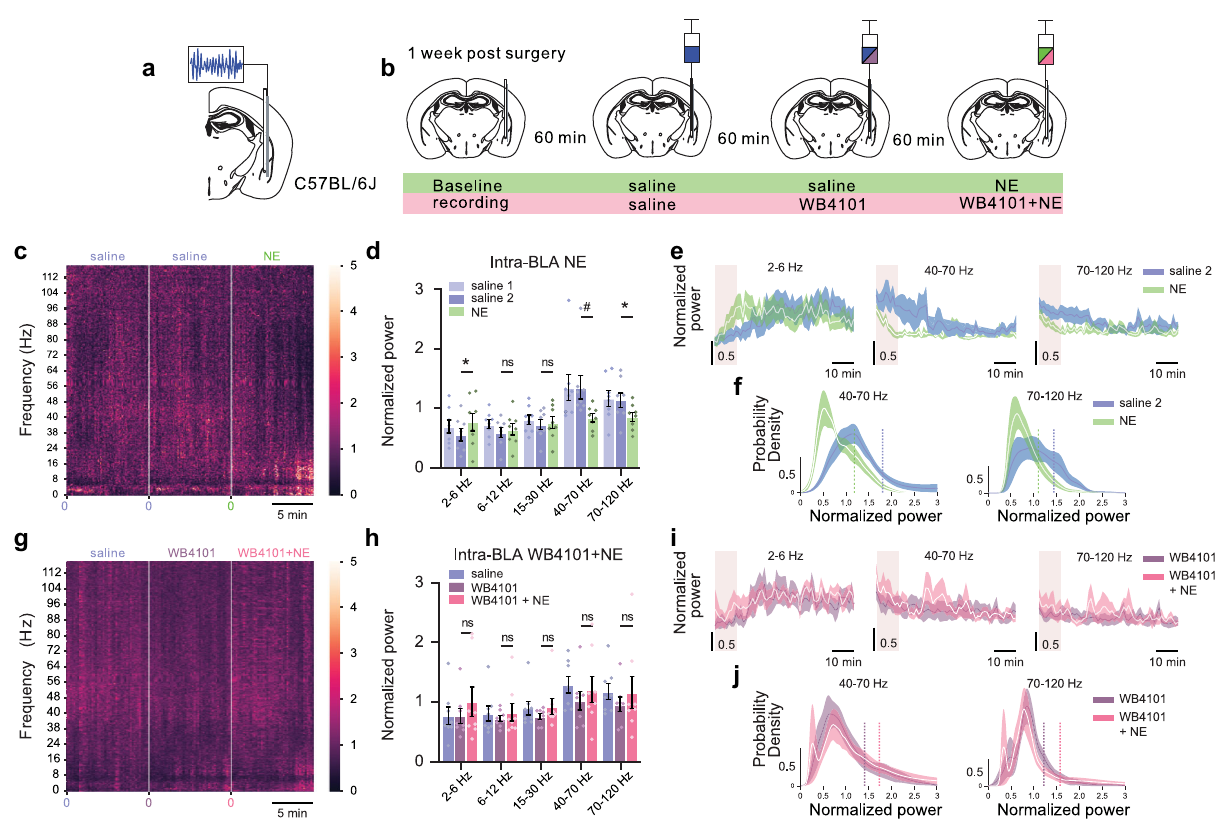
Fig. 7 α 1A adrenoreceptor signaling dynamically reorganizes BLA network states in vivo. a , b Schematics illustrating in vivo paired intra-BLA drug microinfusion and LFP recording paradigm. c Average spectrogram illustrating normalized power (0 – 5: low-to-high power) across frequencies over the fi rst 10min of saline 1, saline 2, and NE treatments. d Mean (±SEM) normalized power across treatments (Saline 1 vs. Saline 2 vs. NE) and frequency bands. Values from fi rst 10min of each treatment were included for analysis. Two-way ANOVA [treatment x frequency], F(1.659, 11.61) = 5.736, p = 0.0223; Tukey ’ s multiple comparisons test, 2 – 6Hz, p = 0.0319; 6 – 12Hz, p = 0.4088; 15 – 30Hz, p = 0.5979; 40 – 70Hz, p = 0.0784; 70 – 120Hz, p = 0.0131. n = 8 mice. # p = 0.0784, * p <0.05, ns not signi fi cant. e Normalized power across time for 2 – 6Hz (left), 40 – 70Hz (middle), and 70 – 120Hz (right). Values averaged into 1-min bins. Colored lines = average power over time, colored shaded areas = SEM. f Average probability density plots illustrating the distribution of gamma powers across treatments for 40 – 70Hz (left) and 70 – 120Hz (right). Blue/green solid lines = average probability, blue/green-shaded areas = SEM. Vertical lines indicate average threshold value for distribution tails, where threshold = 1 standard deviation above the mean. Paired t -test (two-tailed), saline 2 vs. NE 40 – 70Hz distribution tail powers ( n = 8 mice, p = 0.0351); saline 2 vs. NE 70 – 120Hz distribution tail powers ( n = 8 mice, p = 0.0064). g Average spectrogram illustrating normalized power (0 – 5: low-to-high power) across frequencies over the fi rst 10min of saline, WB4101, and WB4101 + NE treatments. h Mean (±SEM) normalized power across treatments (Saline vs. WB4101 vs. WB4101 + NE) and frequency bands. Values from fi rst 10min of each treatment were included for analysis. Two-way ANOVA [treatment×frequency], F(2.294, 16.06) = 1.250, p = 0.3175; Tukey ’ s multiple comparisons test, 2 – 6Hz, p = 0.3855; 6 – 12Hz, p = 0.7577; 15 – 30Hz, p = 0.5846; 40 – 70Hz, p = 0.6894; 70 – 120Hz, p = 0.8026. n = 8 mice. ns = not signi fi cant. i Normalized power across time for 2 – 6Hz (left), 40 – 70Hz (middle), and 70 – 120Hz (right). Values averaged into 1-min bins. Colored lines = average power over time, colored shaded areas = SEM. j Average probability density plots illustrating the distribution of gamma powers across treatments for 40 – 70Hz (left) and 70 – 120Hz (right). Blue/red solid lines = average probability, blue/red-shaded areas = SEM. Vertical lines indicate average threshold value for distribution tails, where threshold = 1 standard deviation above the mean. Paired t -test (two-tailed), WB4101 vs. WB4101 + NE 40 – 70Hz distribution tail powers ( n = 8 mice, p = 0.3792); WB4101 vs. WB4101 + NE 70 – 120Hz distribution tail powers ( n = 8 mice, p = 0.5200). Source data are provided as a Source Data fi